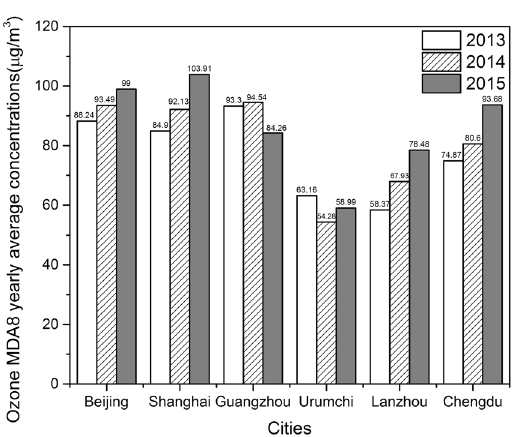
Figure 6. The maximum daily eight-hour average (MDA8) concentrations of annual averaged ground-level ozone in 6 cities during